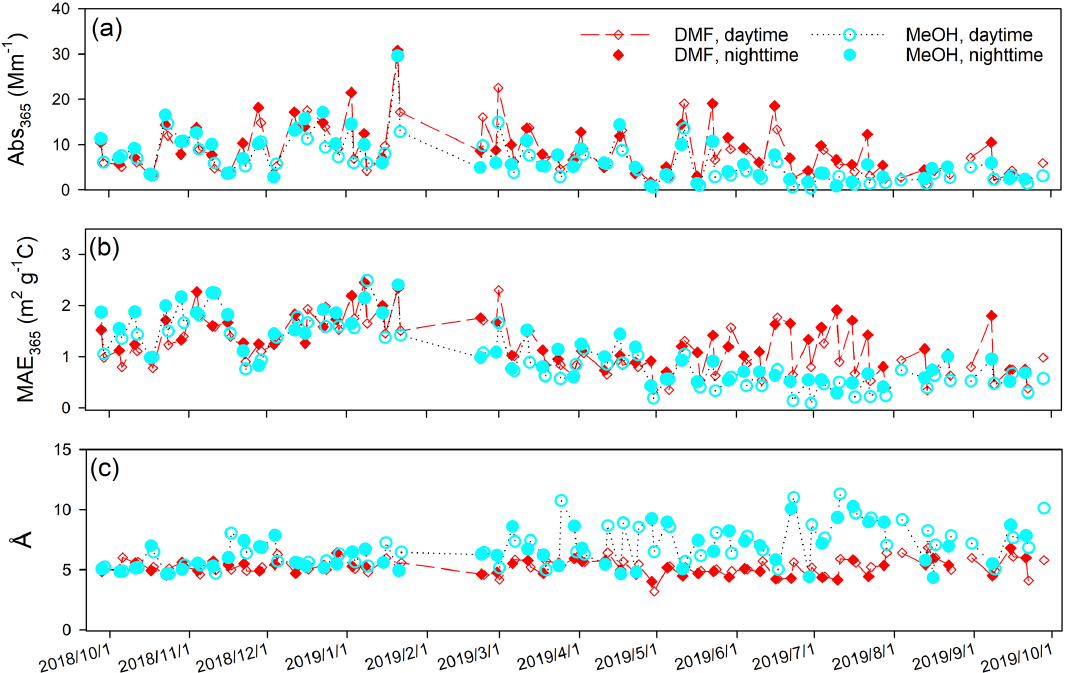
Figure 2. Time series comparisons of light-absorbing properties of DMF and MeOH extracts using artifact-corrected data. MeOH extract data were obtained from Xie et al.